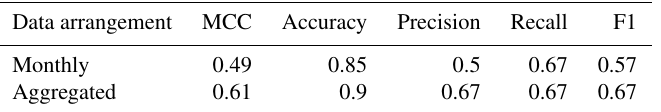
Table C3. Comparison of the random forest model performance between monthly data and aggregated data along reproductive phase of soybean growing season.